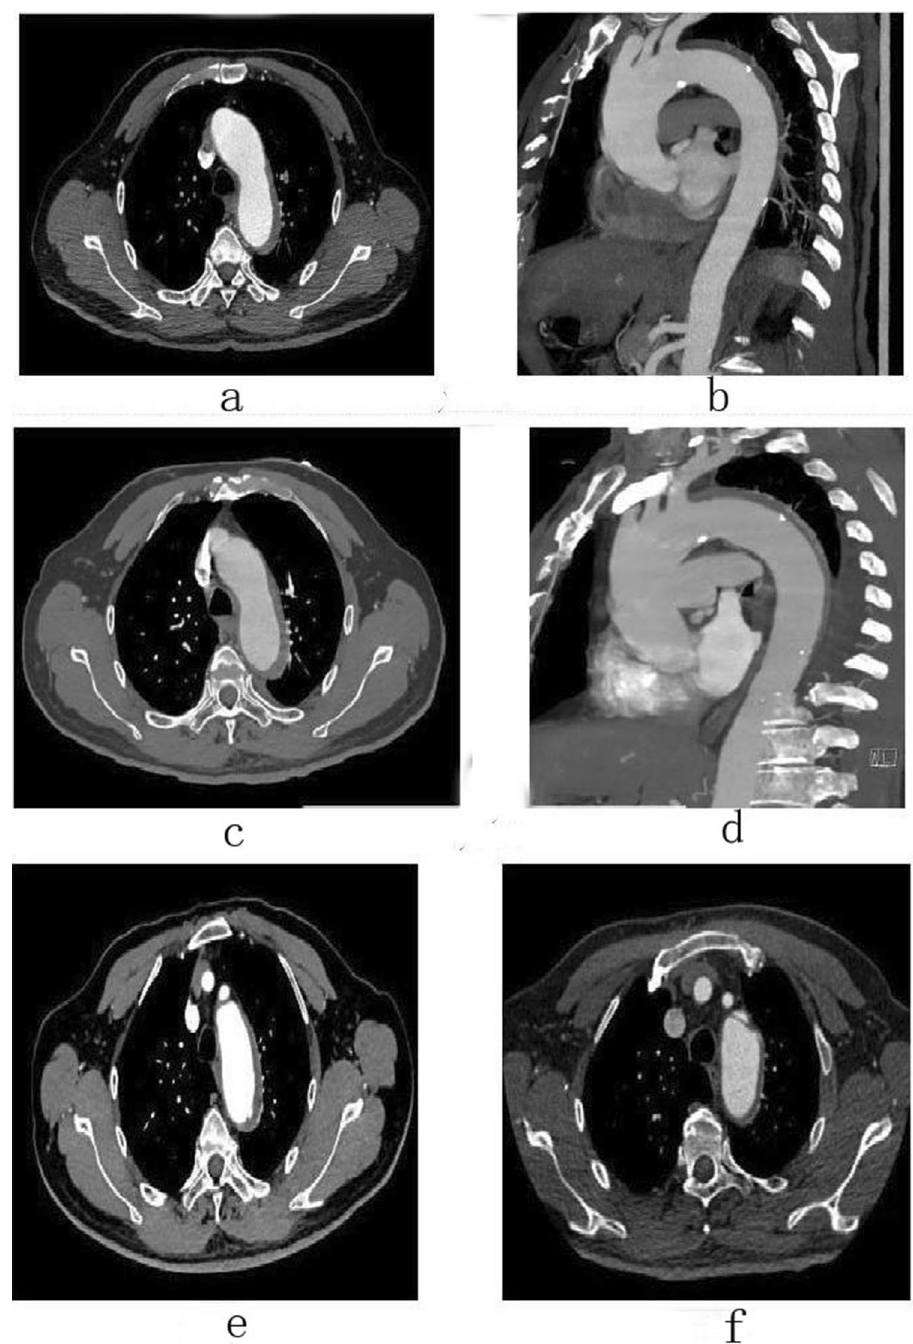
Figure 4. Male, 67 years old, admitted to hospital for “sudden pain in chest for 9 h”, Diagnosis: Stanford type B aortic dissection; Treatment: IMH conservative treatment. CTA of the patient in different periods: ( a ) Admission; ( b ) Admission; ( c ) 3 days after admission; ( d ) 3 days after admission; ( e ) 3 months after admission; ( f ) 11 months after